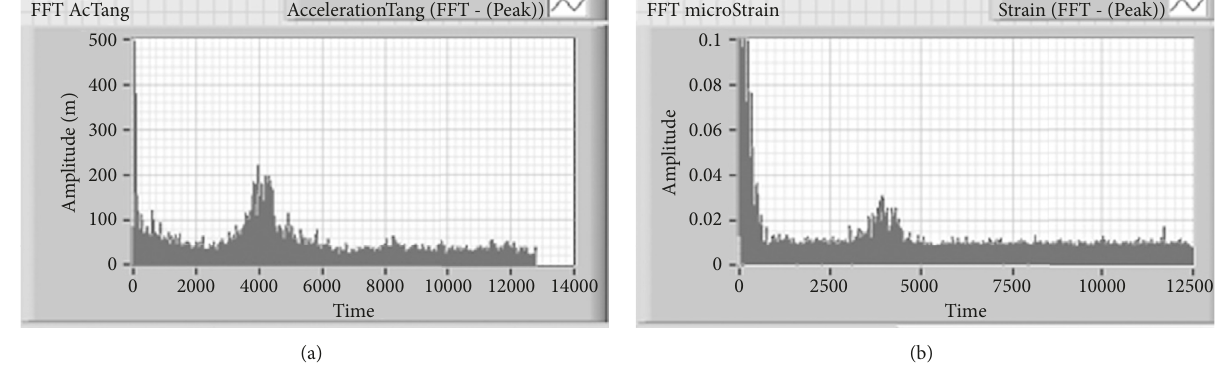
Figure 4: Frequency domain of the acceleration and strain data of test 11.